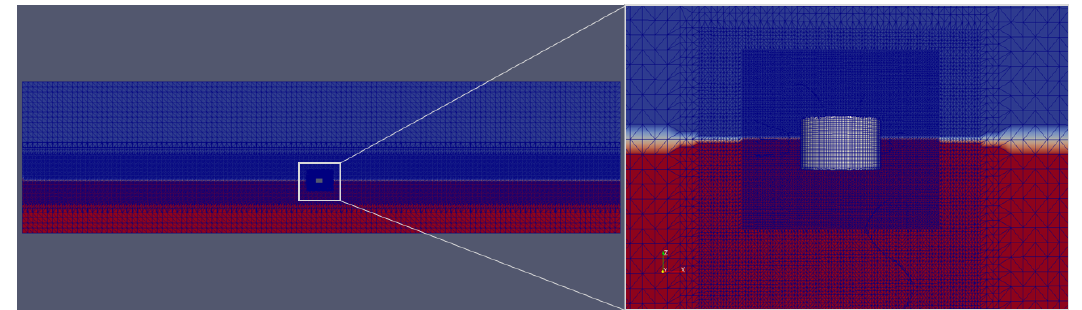
Figure 2. The mesh is refined in a box surrounding the surface, and further refined in the vicinity of the buoy. The color represents the scalar field α . Blue represents α = 0 (air), while red represents α = 1 (water).